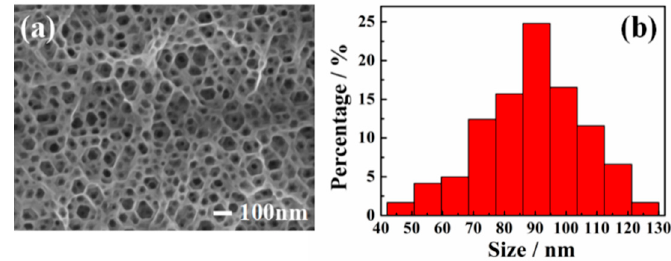
Figure 1. ( a ) SEM image and ( b ) aperture distribution histogram of PGaN electrode.